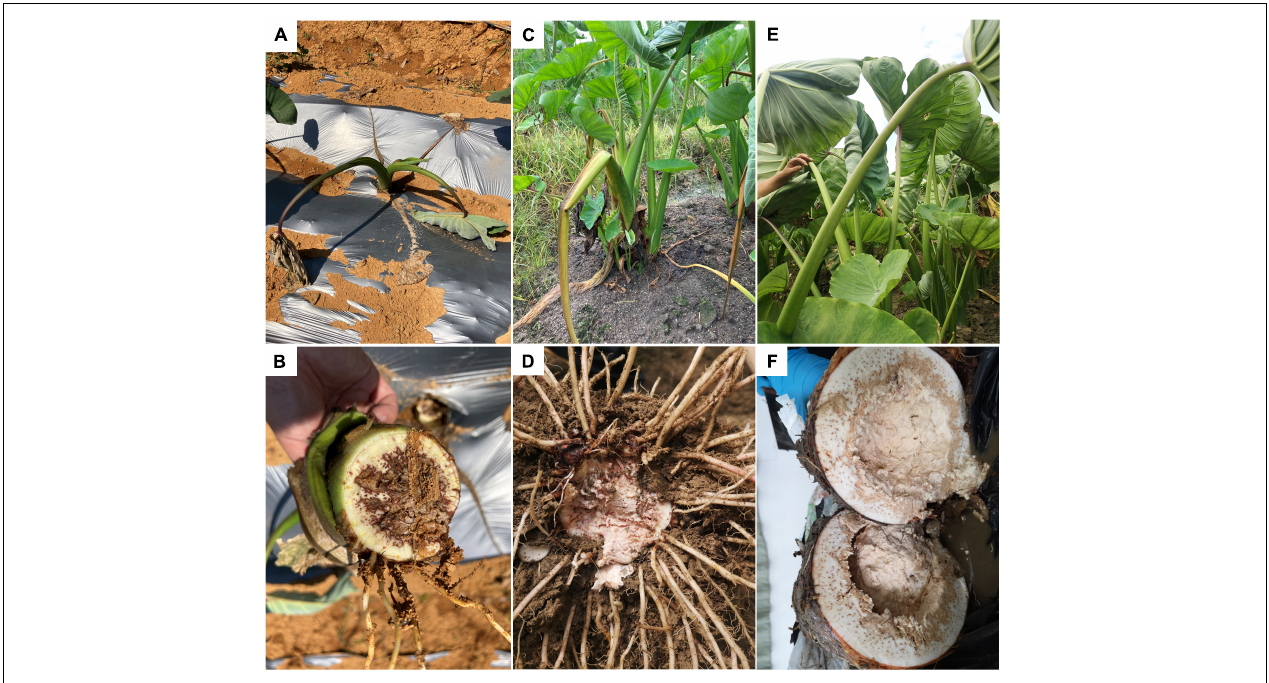
FIGURE 1 | Symptoms of bacterial soft rot of Pinang taro in the field. (A) Diseased plants in early (0–3 months old) seedling stages; (B) Basal stem of a diseased plant in the early seedling stage; (C) Diseased plants in middle (4–6 months old) seedling stage; (D) Diseased bulb in middle seedling stage; (E) Diseased plants in late (7–8 months old) seedling stage; (F) Diseased bulb in late seedling stage.